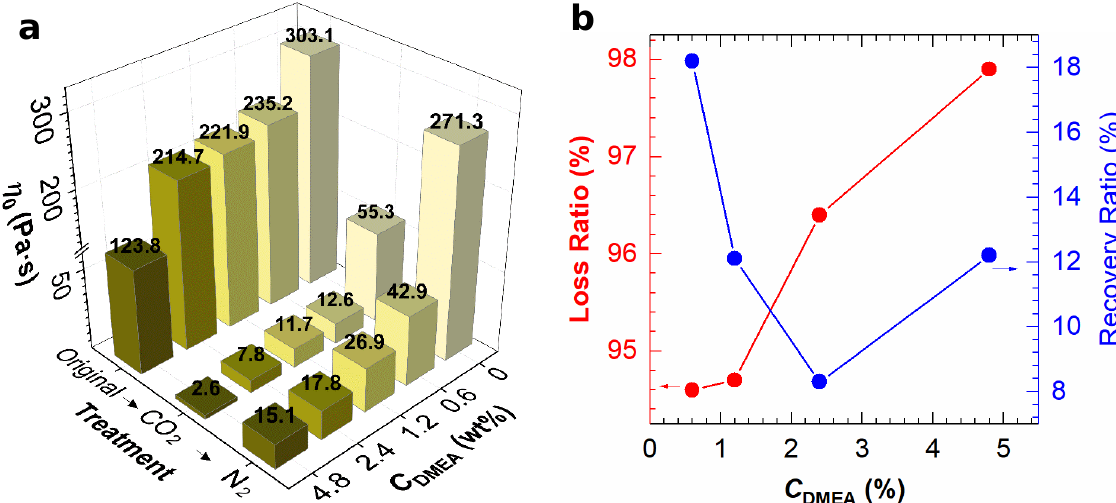
Figure 3. ( a ) Variation in η 0 of 0.65 wt% NaPAA solution with different DMEA concentrations before and after bubbling CO 2 and N 2 , and ( b ) loss and recovery ratios of η 0 for 0.65 wt% NaPAA solution with different DMEA concentration after treatment of CO 2 and N 2 at 25 °C.